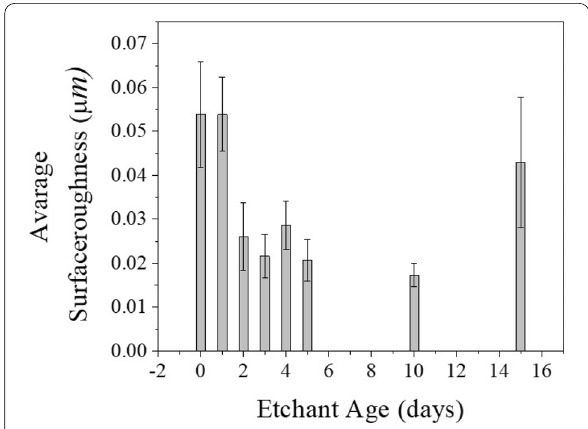
Fig. 7 Average etched surface roughness of silicon in 10 M NaOH without and with addition of 12% NH 2 OH at 70